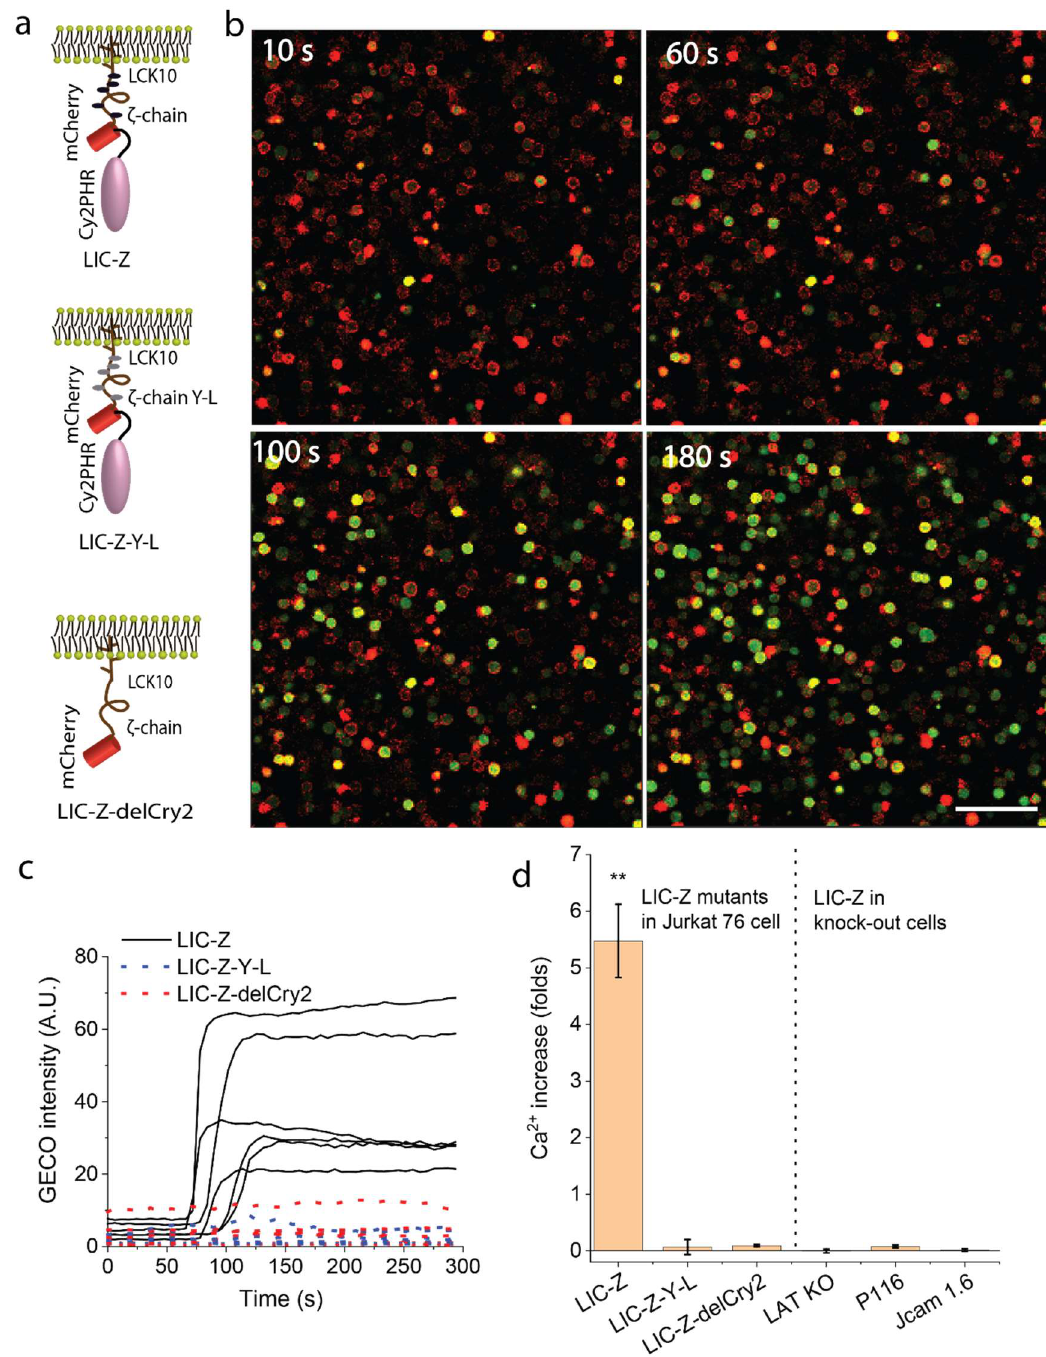
Figure 2. LIC-Z clustering induces Ca 2+ flux in Jurkat cells. ( a ) Schematics of LIC-Z (top), signaling incompetent LIC-Z-Y-L (middle), and light insensitive LIC-Z-delCRY2 (bottom). ( b ) Confocal images of Ca 2+ flux in Jurkat 76 cells co-transfected with LIC-Z (red) and Ca 2+ sensor G-GECO (green). Images were taken at the indicated time points after irradiation with blue light. Scale bar = 150 µm ( c ) G-GECO intensity traces over time for single cells expressing LIC-Z (solid line), LIC-Z-delCRY2 (red dotted line) and LIC-Z-Y-L (blue dotted line). ( d ) Quantification of Ca 2+ flux, as fold increase over baseline level, in Jurkat 76 cells expressing LIC-Z, LIC-Z-Y-L and LIC-Z-delCry2, and LIC-Z expressed in Jurkat cells deficient of LAT (LAT KO), Zap70 (P116) or Lck (JCam 1.6). In ( d ), data are mean and standard error of n = 30 cells. ** p < 0.001 between the first column to the rest of all columns (one-way ANOVA with Fisher LSD post hoc test).